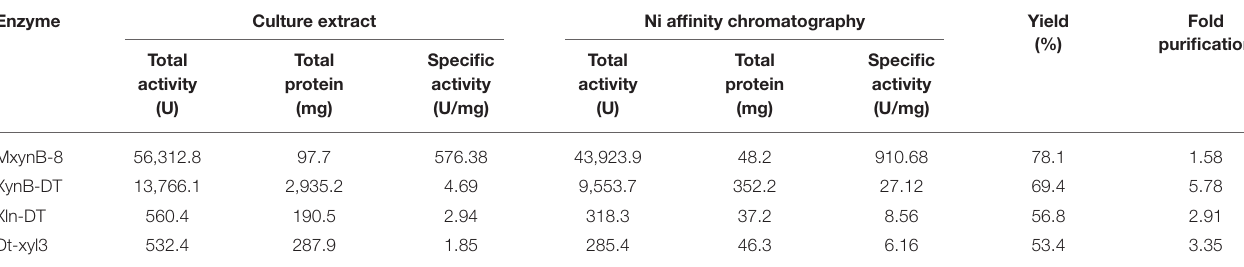
Fold (%) purification